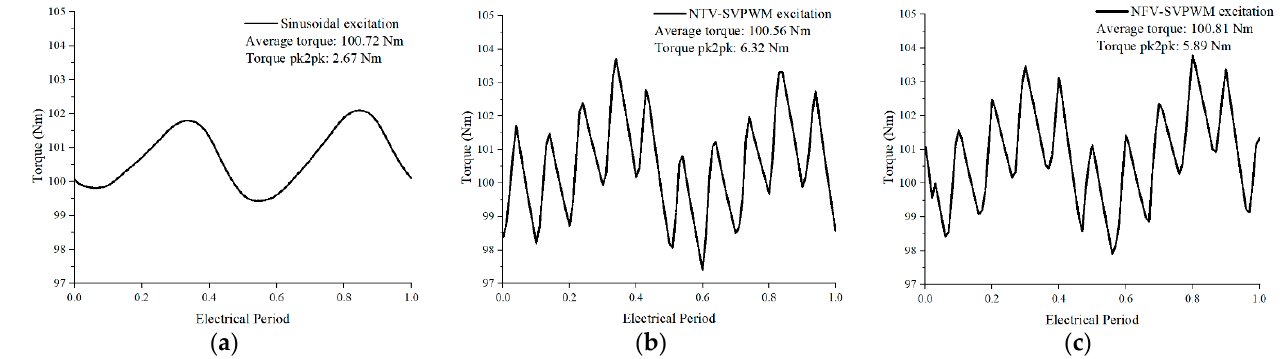
Figure 20. Current excitation under different modulation algorithm: ( a ) ideal sinusoidal, ( b ) NTV- SVPWM, and ( c ) NFV-SVPWM.